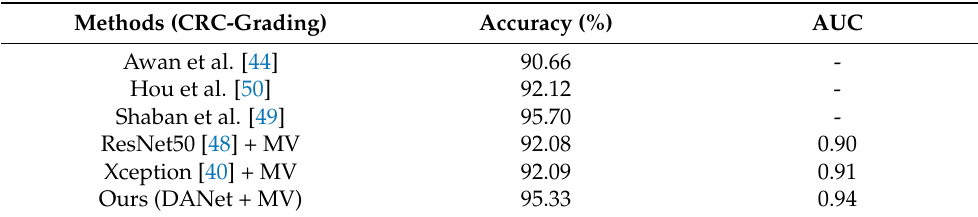
Table 2. Comparison with the previous methods on the CRC grading dataset.